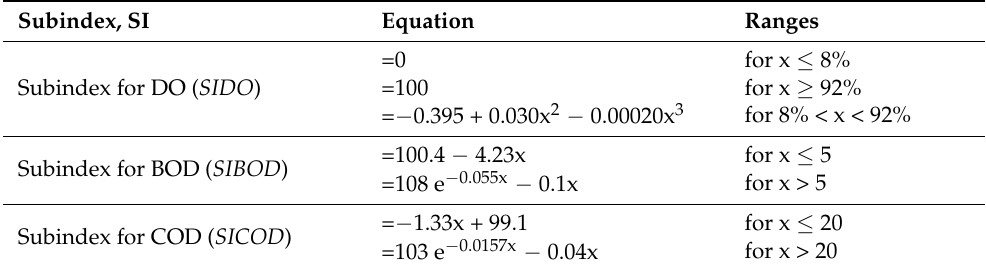
Table 1. Best-fit equations for the estimation of parameter subindex values. Subindex,